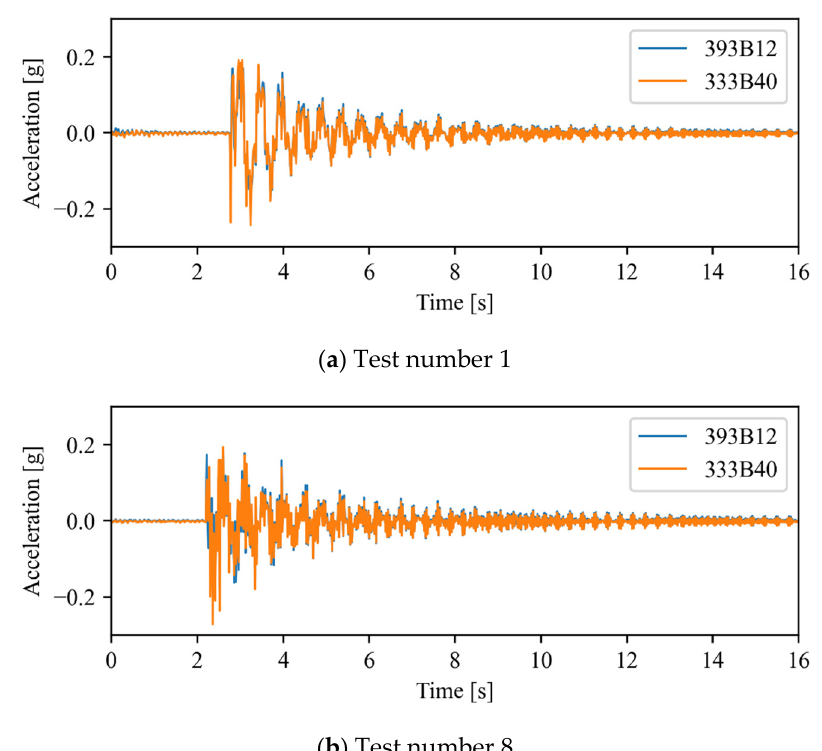
Figure 8. Time series comparison (393B12 vs. 333B40).